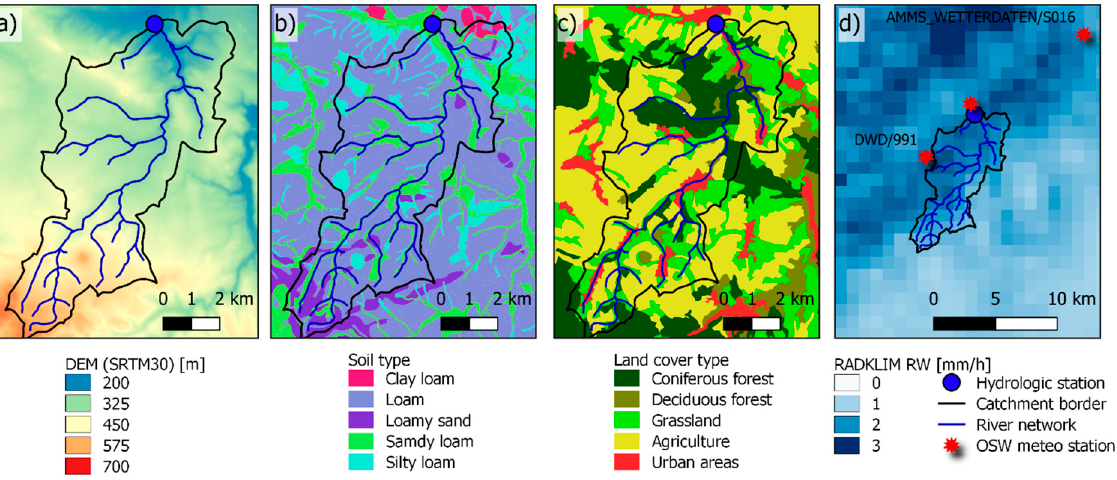
Figure 3. An overview of the model setup, exemplified for the Kreischa catchment: ( a ) a topographic map based on the digital elevation model STRM30, ( b ) land use map simplified from CORINE2012, ( c ) soil map simplified from BK50, ( d ) RADKLIM-RW exemplary for one hour and meteorological stations available from